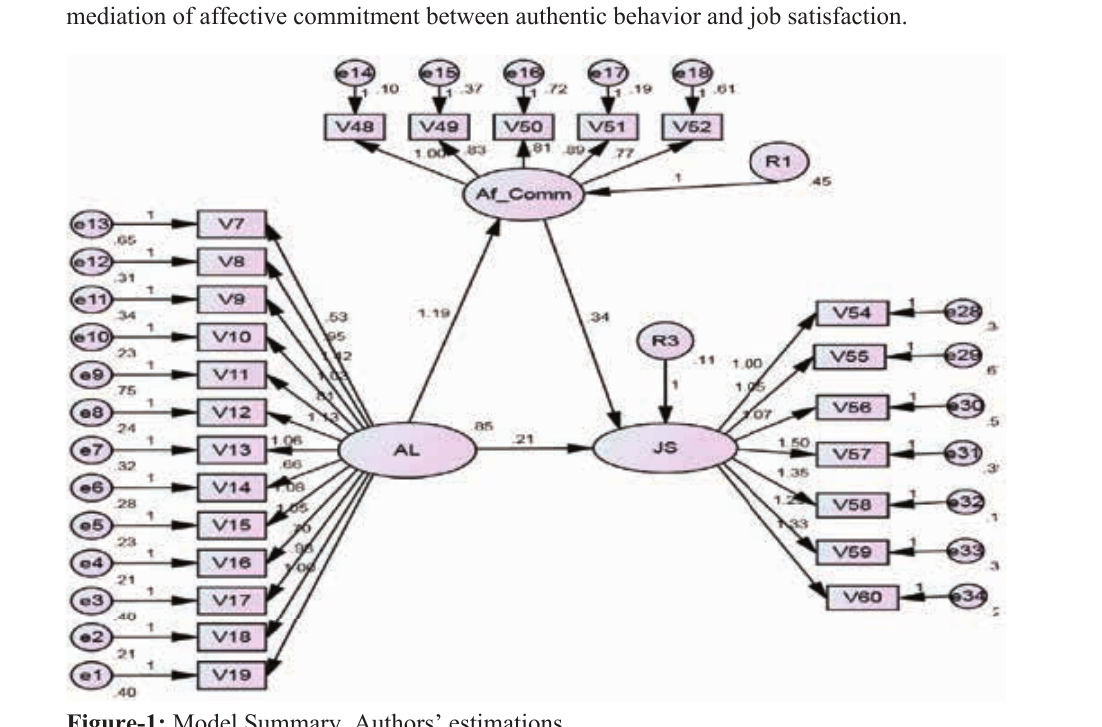
Figure-1: Model Summary. Authors’